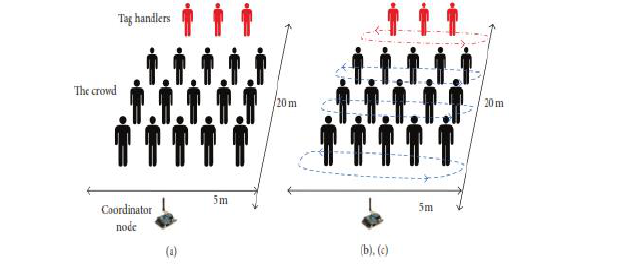
Table 1 : Shows comparative study of different techniques Figure 2: figure a. shows the experimental setup where all elements are static in nature and in figure b and c the crowd having movements within a given area.